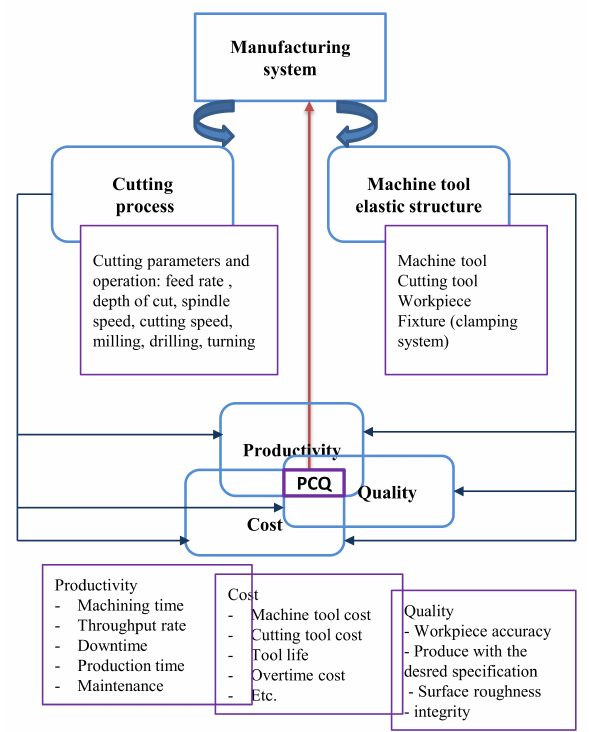
Figure 4. Conceptual map for modelling.